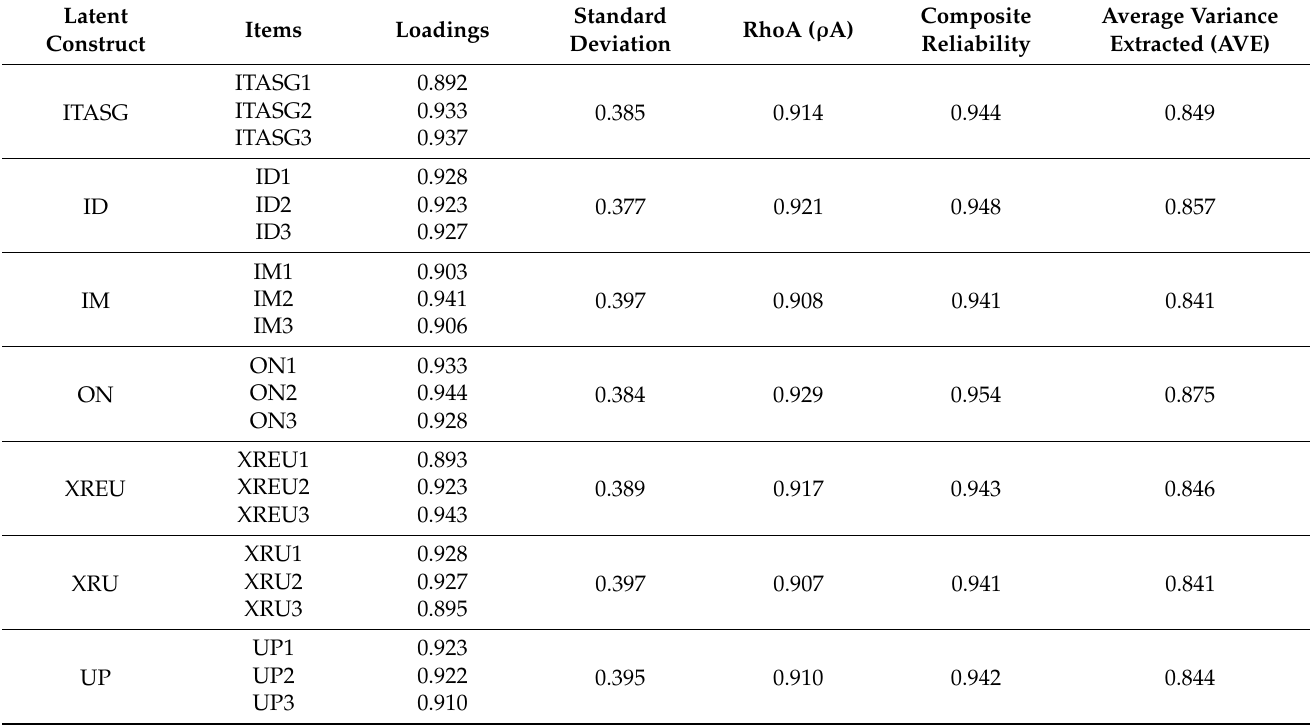
Table 4. Convergent Validity and Construct Reliability.